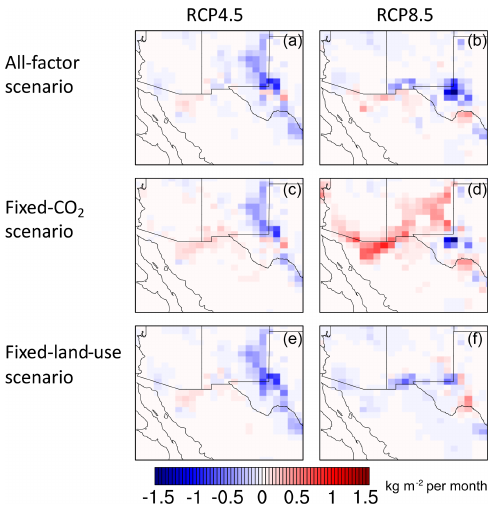
Figure 2. Simulated changes in spring averaged monthly mean dust emission in southwestern North America under the three condi- tions for RCP4.5 and RCP8.5. Changes are between the present day and 2100, with 5 years representing each time period. Panels (a) and (b) show results for the all-factor condition, panels (c) and (d) are for the fixed-CO 2 condition, and panels (e) and (f) are for the fixed-land-use condition. Cases are as described in Fig. 1. Results are generated offline using the GEOS-Chem emission component (HEMCO).